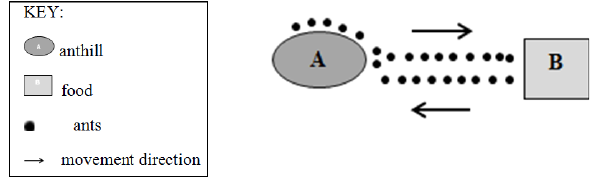
Figure 1: A diagram showing ants’ behaviour when searching for